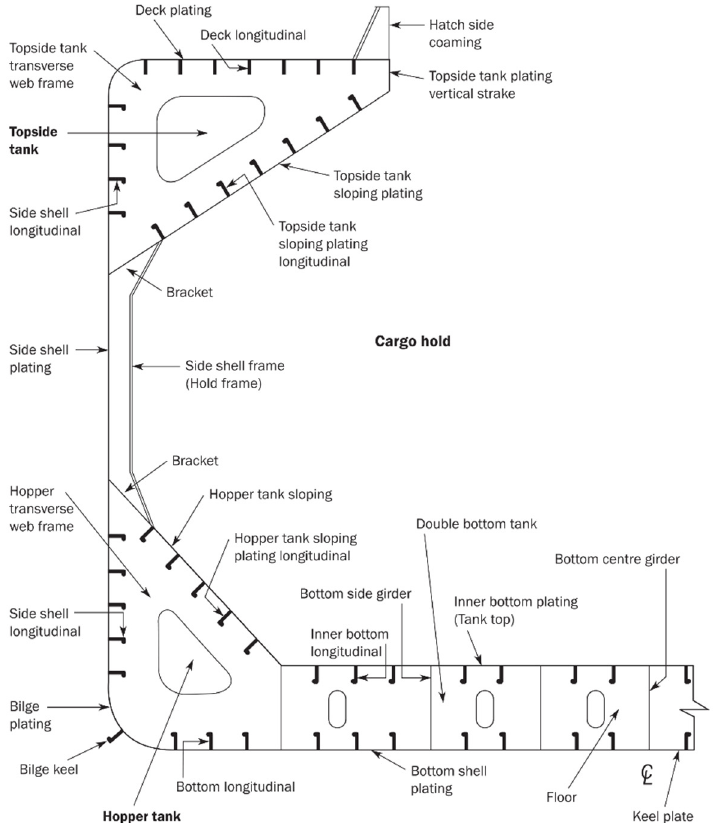
Figure 2. Schematic of a cargo hold’s compartments and supporting members (Common Structural Rules for Bulk Carriers and Oil Tankers, January 2019).